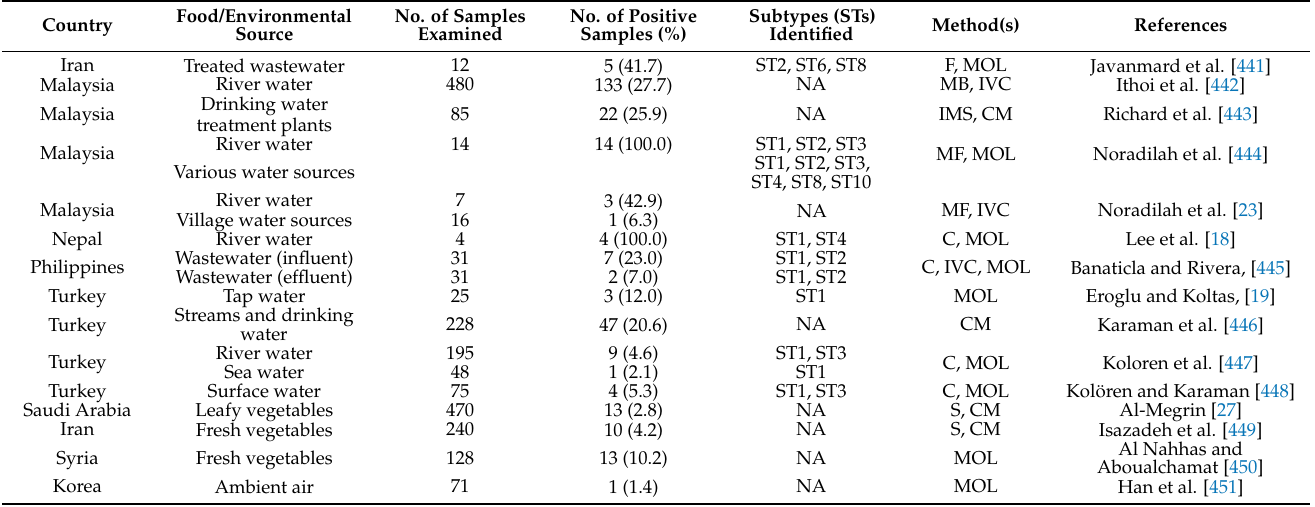
C—Centrifugation, CM—Conventional microscopy, F—Filtration, IMS—Immunomagnetic separation technique, IVC—In vitro cultivation, MB—Membrane filtration, MOL—Molecular technique, S—Sedimentation, NA—Not